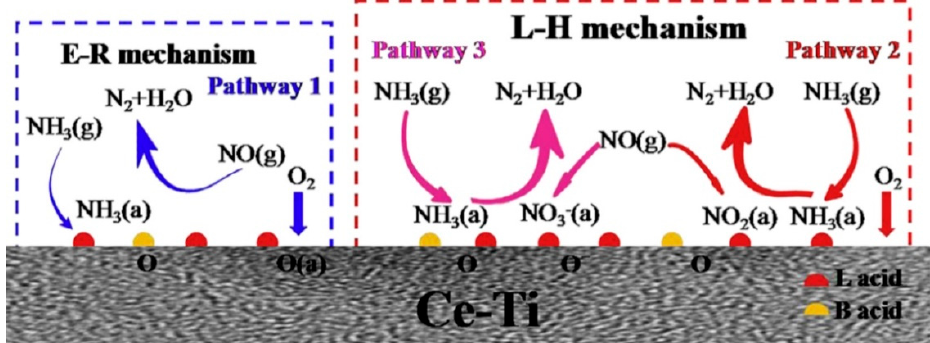
Figure 5. Proposed NH 3 -SCR reaction mechanism over Ce a Ti 1 − a catalysts [39].